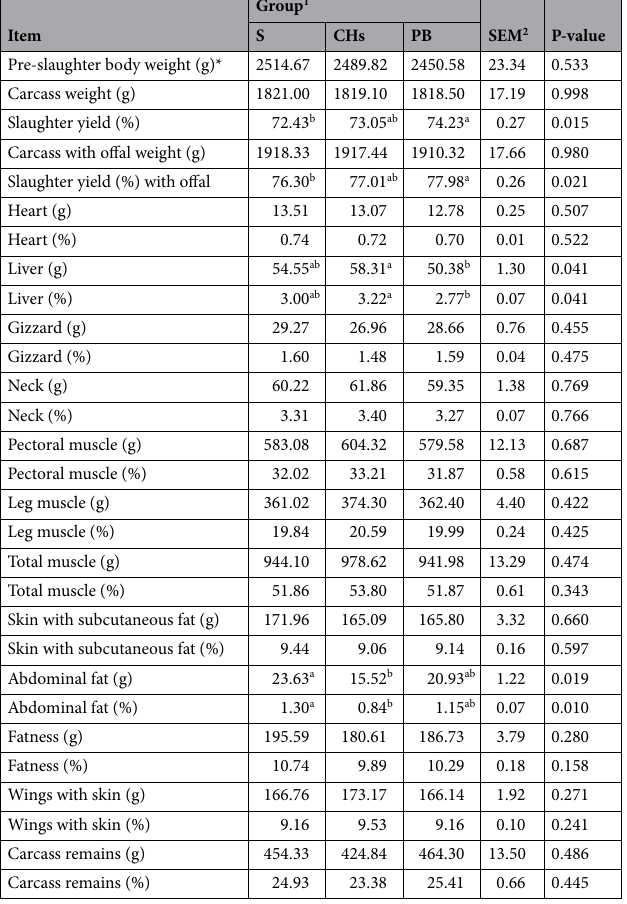
Table 4. Carcass yield of broiler chickens. *The weight of chosen broilers for slaughter according to the methods; a,b different letters in the row indicate statistically significant differences between the groups, P-value < 0.05; letters are given from the highest (a) to the lowest value (…) ; 1 , S, chopped wheat straw bedding; CHs, crude coffee husks bedding; PB, pelleted bedding with 50% of chopped wheat straw and 50% of coffee husks; 2 , SEM, standard error of the